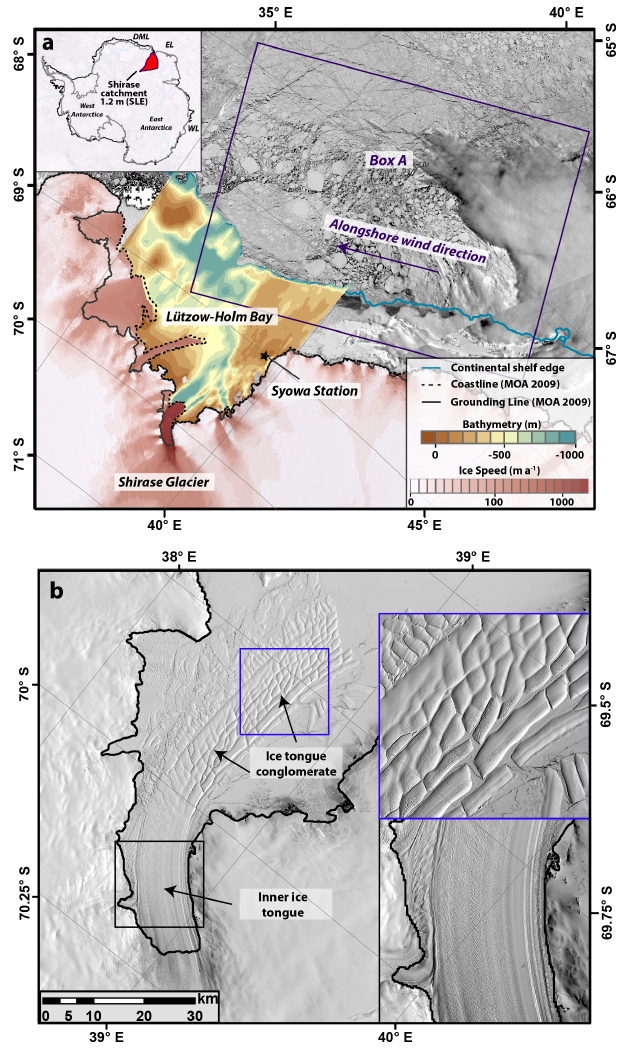
Figure 1. (a) MODIS image of Lützow-Holm Bay and Shirase Glacier from 4 November 2019 obtained from NASA WorldView. Overlain is the ITS_LIVE composite velocity product in logarith- mic scale (Gardner et al., 2018, 2020), a 1000m bathymetric con- tour obtained from BedMachine (Morlighem et al., 2020) which is taken as the continental shelf boundary and bathymetry of Lützow- Holm Bay (Kusahara et al., 2021a). Note the deep trough connect- ing Shirase Glacier to the open ocean. The locations of the Syowa research station and Box A, the region where ERA5-derived winds were extracted, are also shown. The initials in the inset refer to the following: DML (Dronning Maud Land), EL (Enderby Land) and WL (Wilkes Land). (b) Landsat-8 image from November 2020 showing the structure of the Shirase ice tongue. The blue box is a zoomed-in section of the ice tongue conglomerate that is uncon- strained. The black box is a zoomed-in section of the inner section of the ice tongue that is constrained by fjord walls on either side. The black line in both images is the MODIS 2009 grounding line and coastline (Scambos et al., 2007; Haran et al., 2019). Landsat images are courtesy of the U.S. Geological